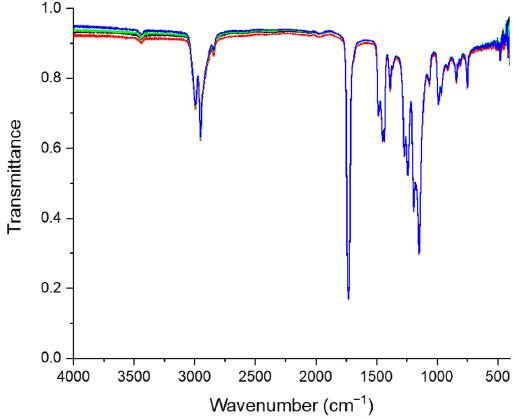
Figure 4. FT-IR spectra of a PMMA thin film at 10 − 7 mbar pressure and acquired after 0 (black line), 6 (red line), 25 (green line) and 30 (blue line) hours (room temperature).